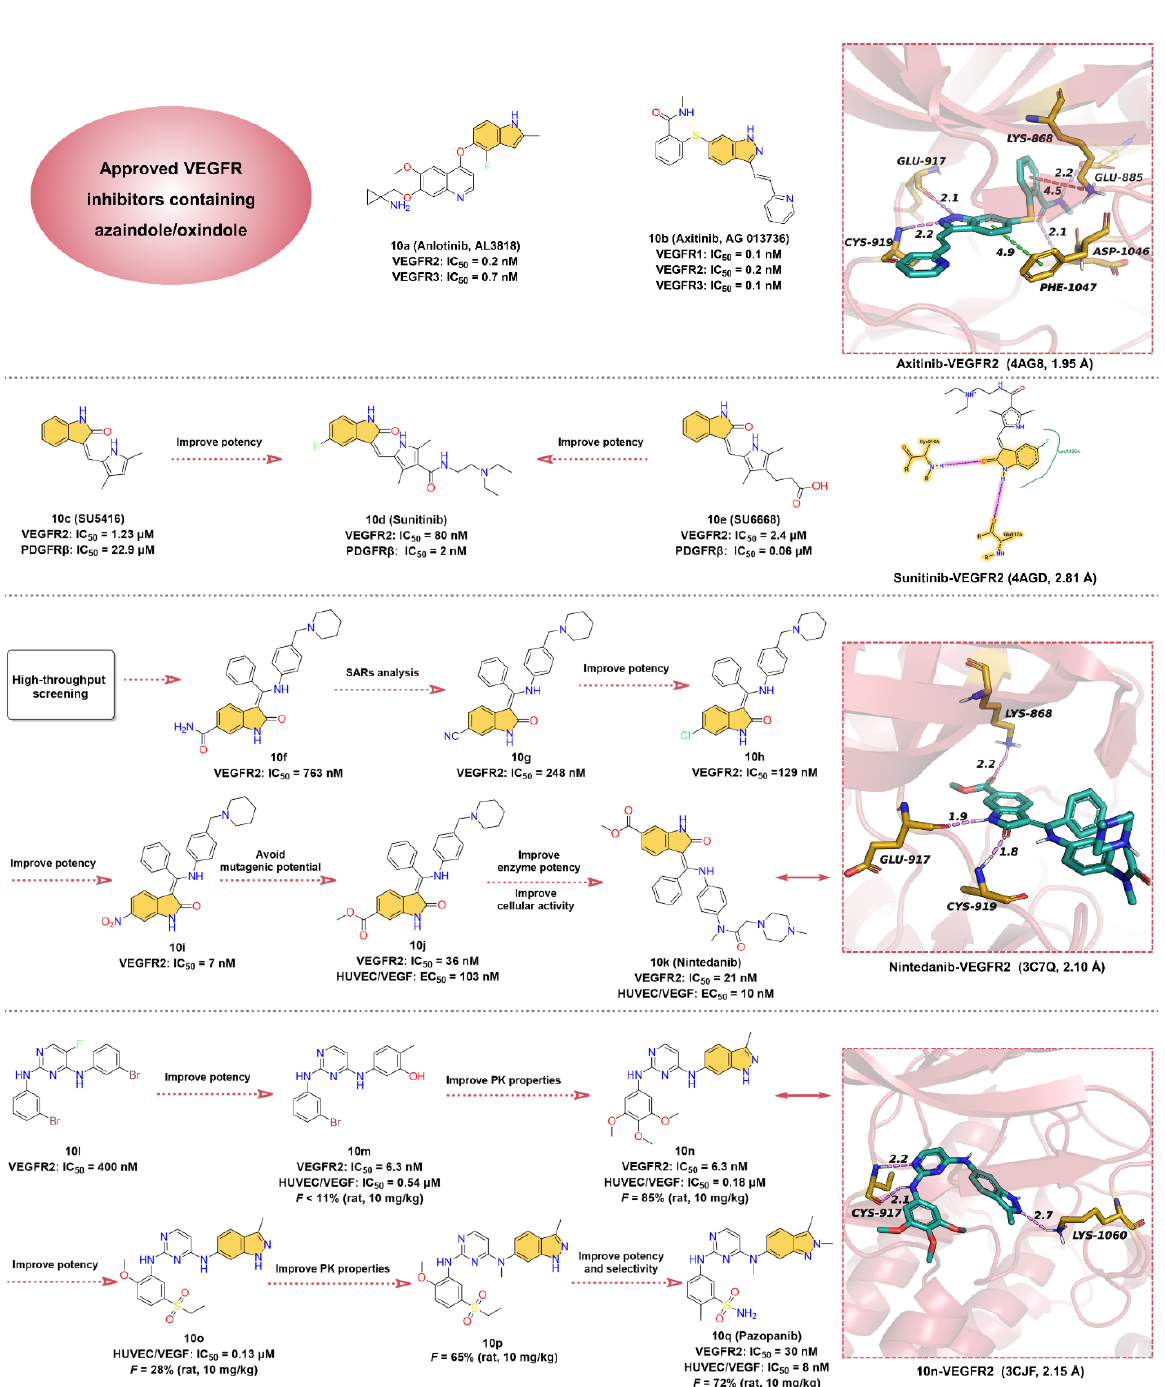
Figure 10. Key medicinal chemistry optimization of VEGFR inhibitors along with the binding models with VEGFR2.